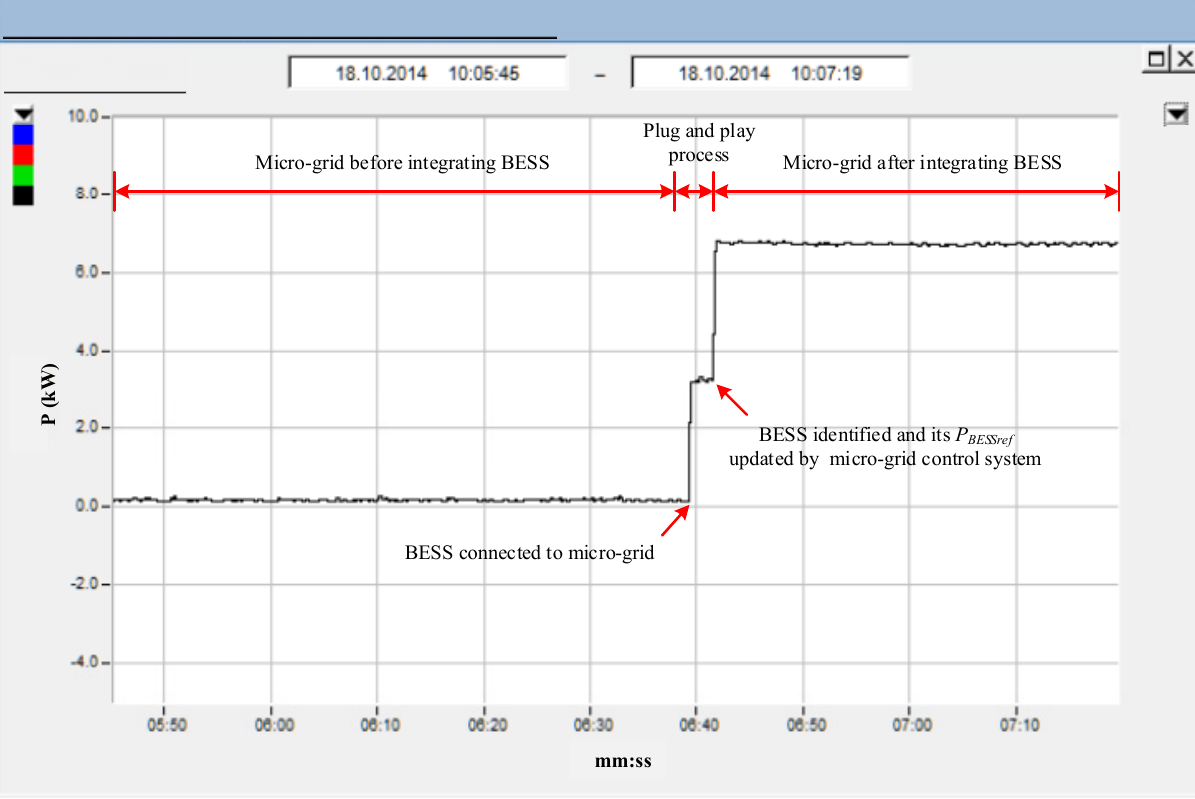
Figure 7. Power monitoring curves of